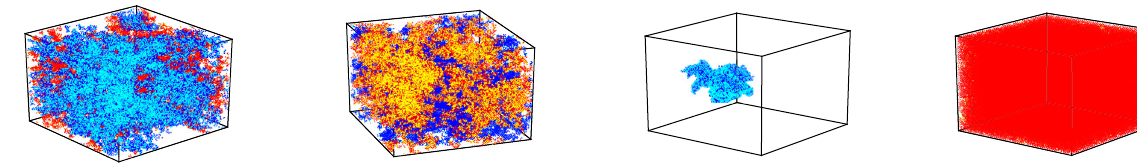
≲ 0 . 6 , the largest R FIG. 3. Left two panels: At intermediate values of dilution 0 . 35 ≲ n A (dark blue bulk with light blue surface) vac region and the largest R B -type region (red bulk with yellow surface) of the Dulmage-Mendelsohn decomposition of a site-diluted cubic lattice both percolate, as shown in this L ¼ 100 example from two different vantage points in these panels. Right two panels: For smaller n , in each sample, either the largest R A -type region is small and the largest R B -type region percolates or vice versa, as is evident from vac individual snapshots of the largest R A (dark blue bulk with light blue surface) and the largest R B region (red bulk with yellow surface) in the example shown. For such low dilution, each sample thus spontaneously breaks the sublattice symmetry that characterizes the ensemble of site-diluted lattices we consider. See Secs. I – III for further